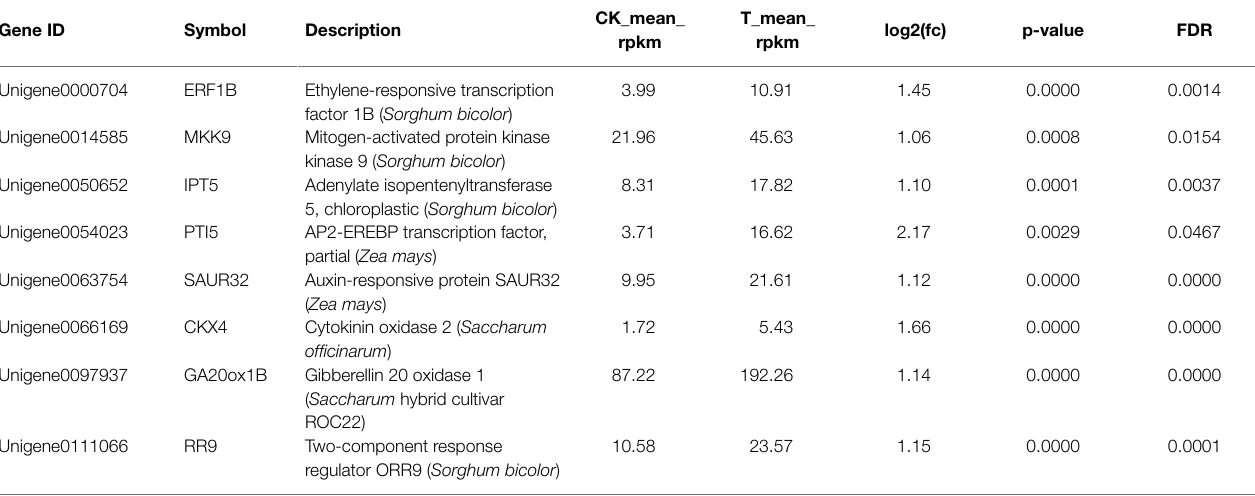
TABLE 2 | RNA-seq results of selected genes for qRT-PCR